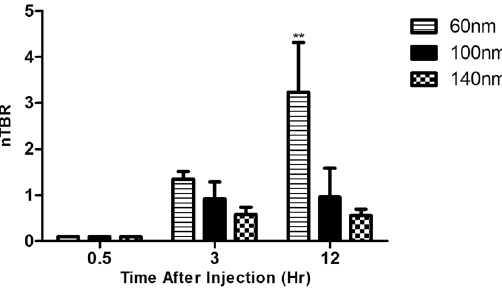
Figure 4. Time course of signal intensity of different size liposomes. The results summarize two experiments, n = 4 for each time point. nTBR = normalized TBR (relative to TBR of free ICG) ** p = 0.006.